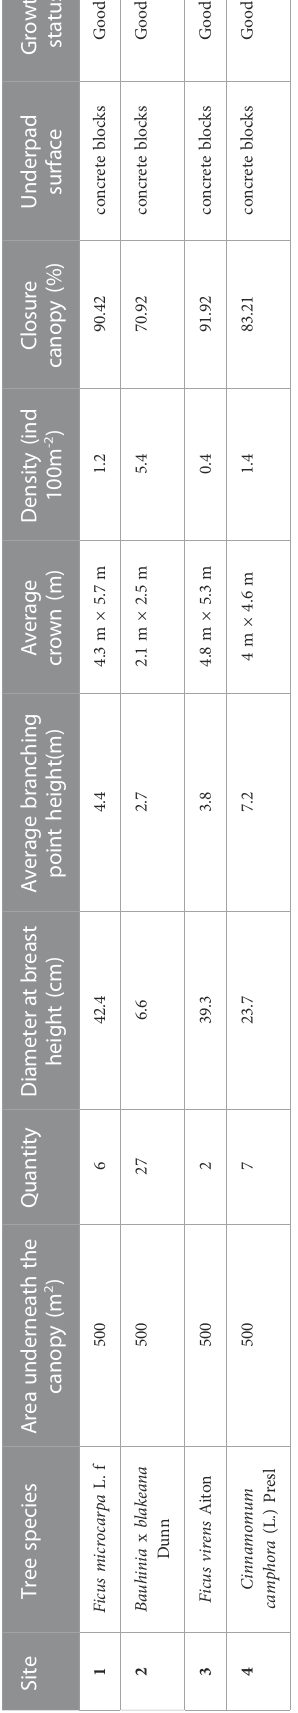
diurnal air temperature variation underneath the canopies among the four tree species was low. On the contrary, it was high in summer. Furthermore, the difference in the diurnal air temperature variation range was not relatively signi fi cant, but the difference in degree was higher in the summer than that in winter. During the 7-day observation in the winter, the air temperature change range of the areas underneath the canopies of F. microcirpa , F. virens , Bauhinia x blakeana , and C. camphora was 14.86 ° C – 20.26 ° C, 14.41 ° C – 20.01 ° C, 14.24 ° C – 21.39 ° C, and 14.41 ° C – 21.89 ° C, respectively.